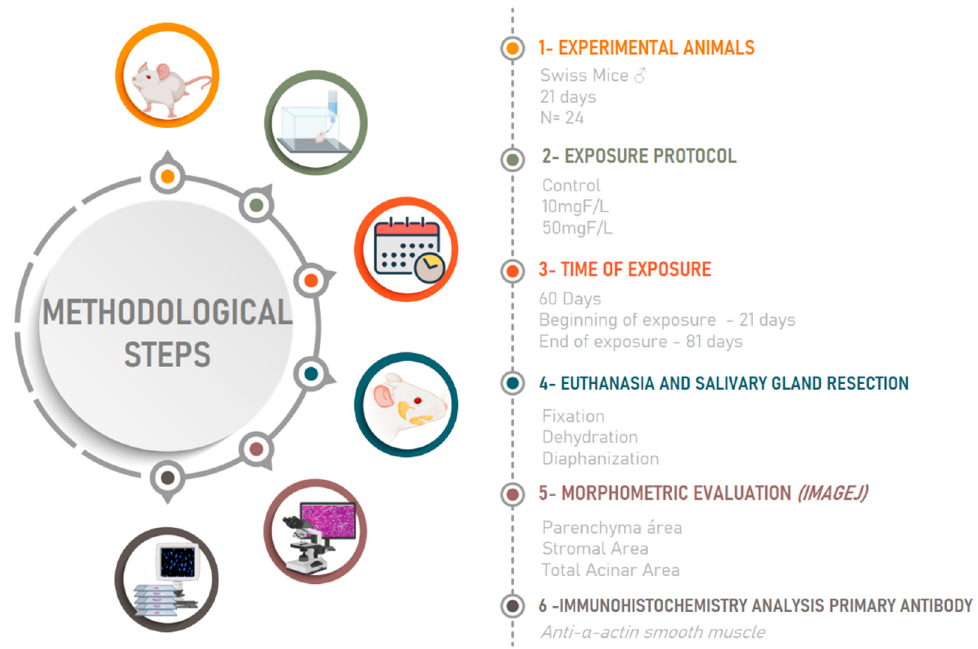
Figure 1. Experimental protocol of the study. In 1, description of experimental animals; in 2, the method of exposure to fluoride (F) at 0, 10 or 50 mg F/L; in 3, time of exposure and age at which experiment started and ended; in 4, euthanasia, salivary glands resection and histological processing steps; in 5, morphometric evaluation; and 6, immunohistochemical analyses.